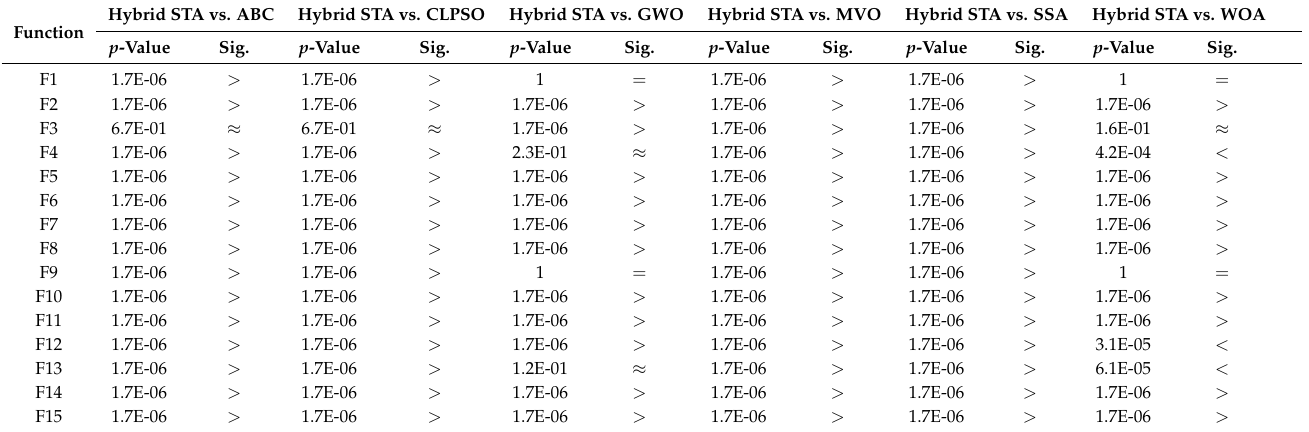
Table 9. Wilcoxon signed-rank test in 20 dimensions.